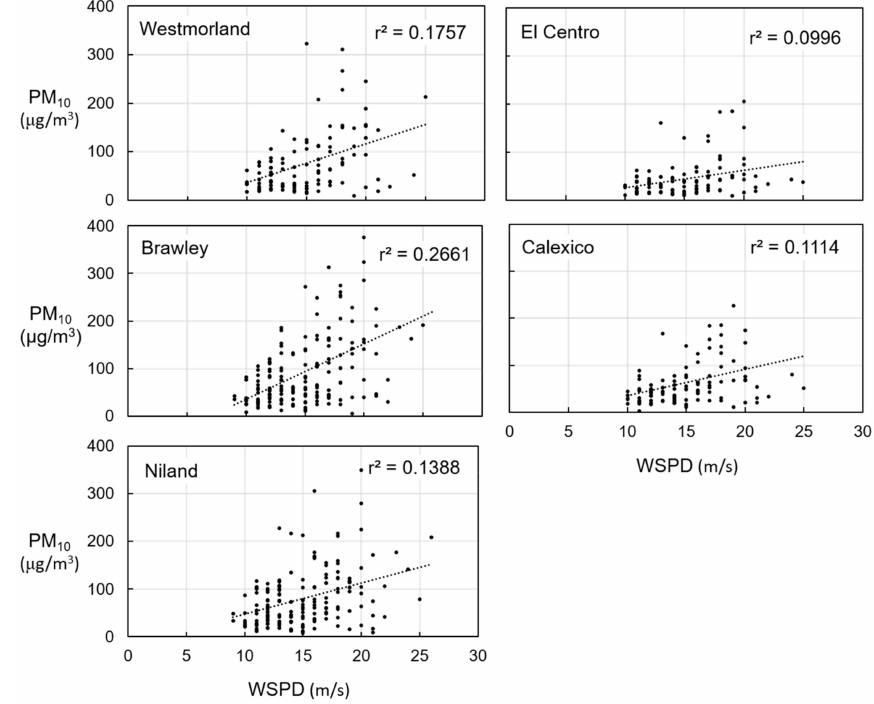
Figure 4. Daily averaged beta-attenuation monitors (BAMS) PM10 concentrations versus daily-averaged wind speed at KIPL for the selected springtime WSW wind events in the Imperial Valley. The coe ffi cient of determination (r 2 ) of the plotted best-fit regression line is indicated on each panel. Data comprise 165 days between 2013 and 2019 for Brawley and Niland, and 104 days between 2016 and 2019 for Calexico, El Centro, and Westmorland. Criteria of event selection is given in Section